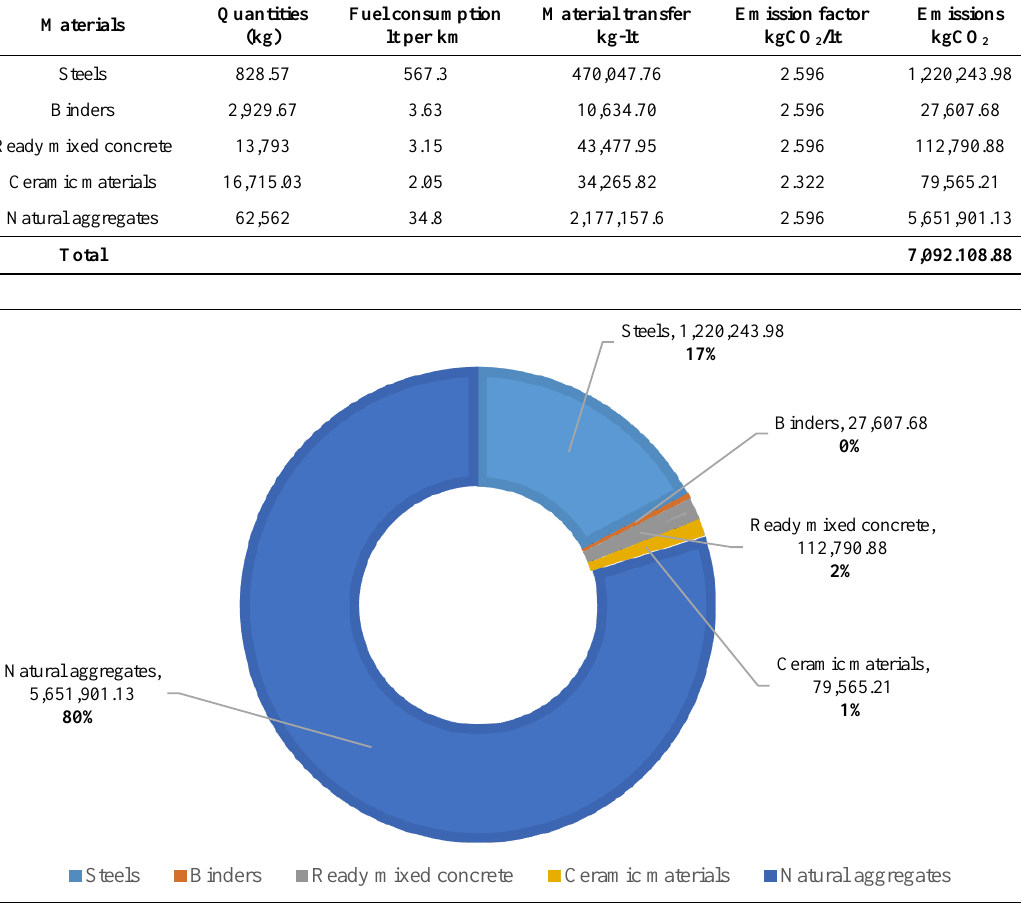
Figure 2. CO 2 emissions from transfers of construction materials (kgCO 2